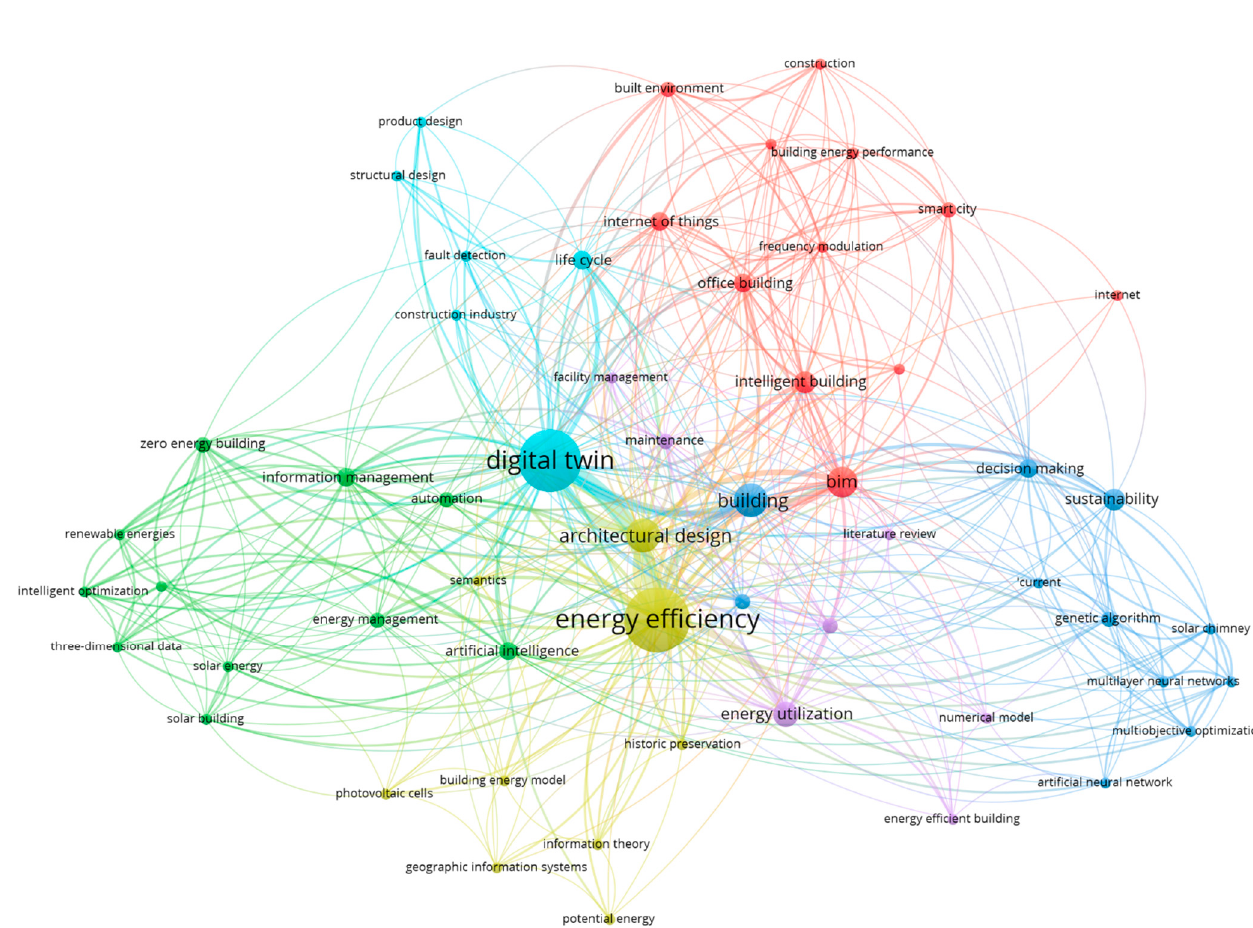
Figure 4. Keyword co-occurrence network.